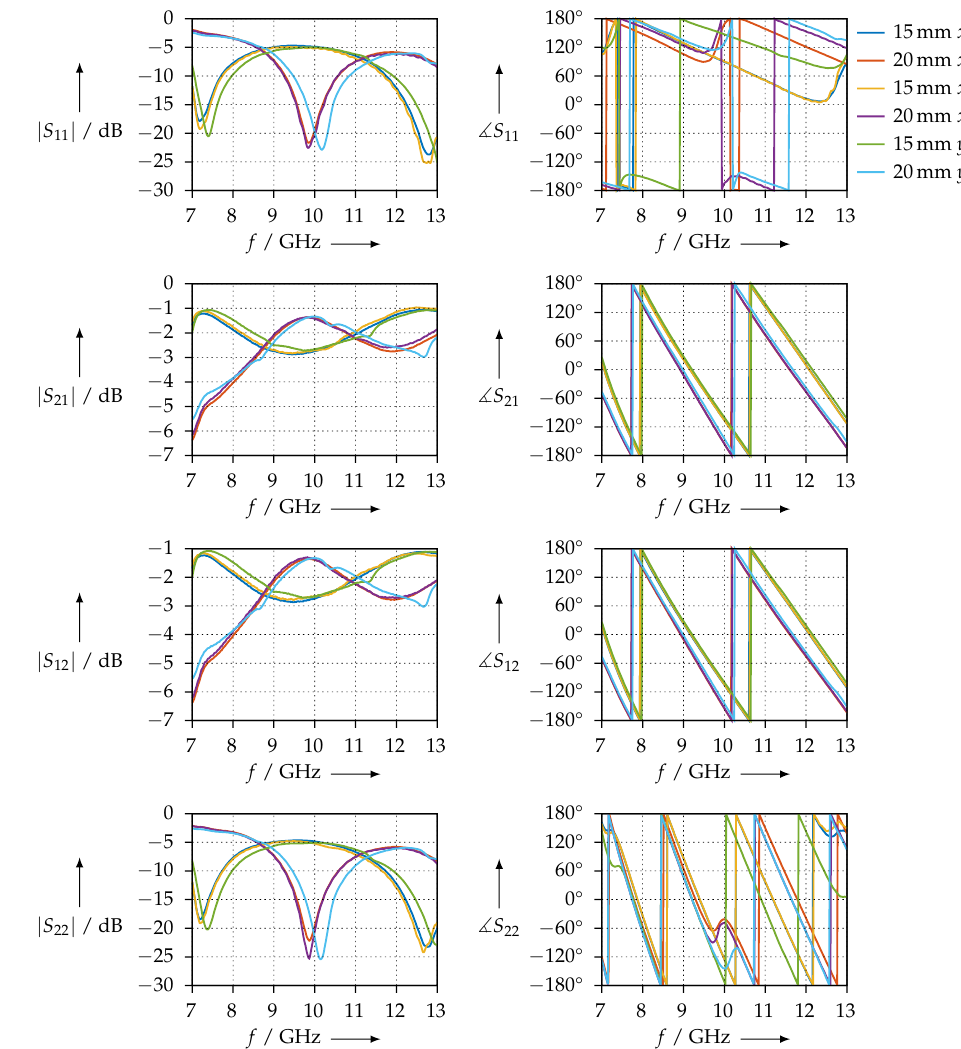
Figure 27. Magnitude and phase of the transmission and reflection S-parameters of the KIM material samples, measured in the WR90